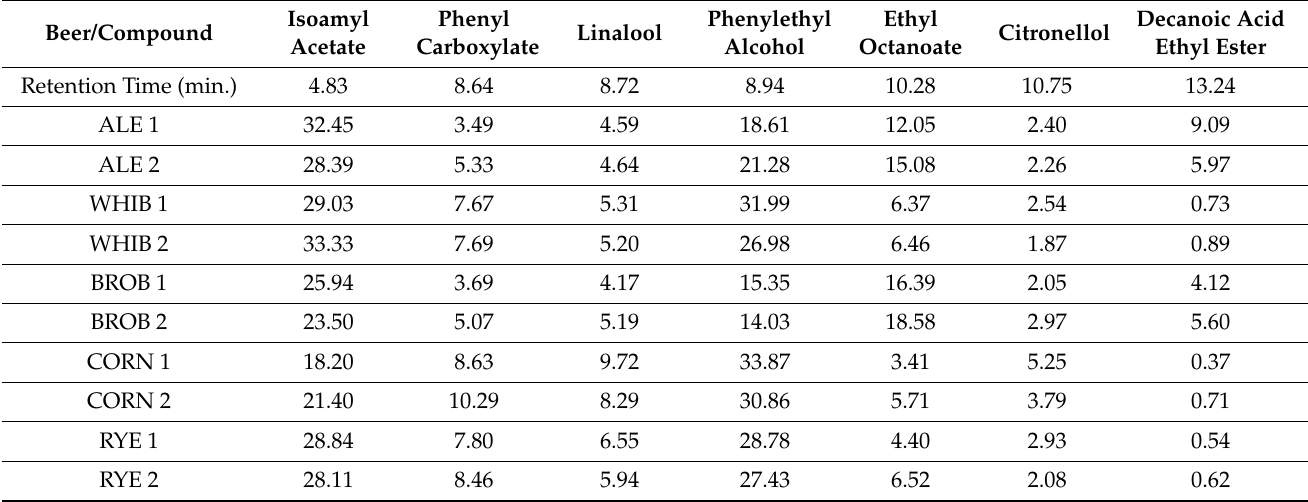
Table 4. Comparison of retention times and peak areas (%) of volatile compositions in craft bread